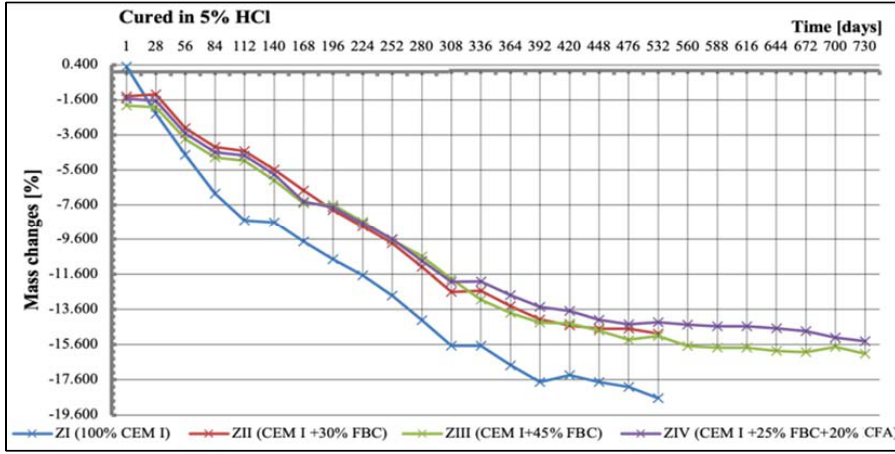
Figure 18. Mass changes of mortars cured in 5% HCl solution for 730 days.